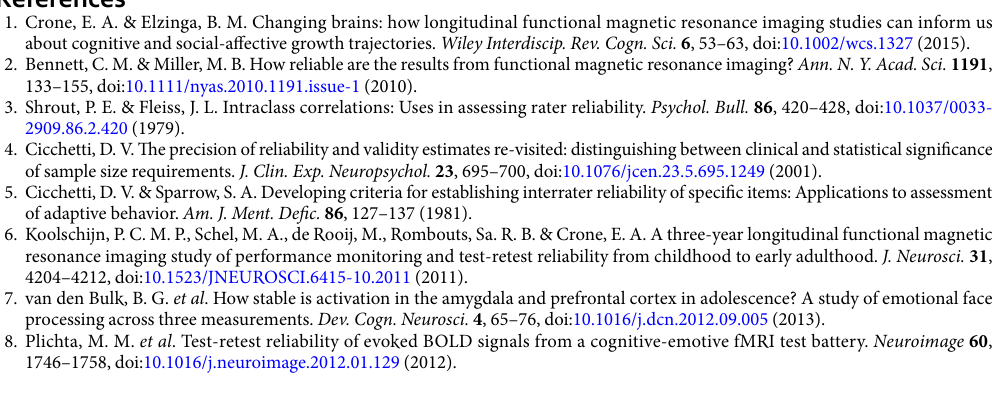
9 Scientific RepoRts | 7: 2287 | DOI:10.1038/s41598-017-02334-7